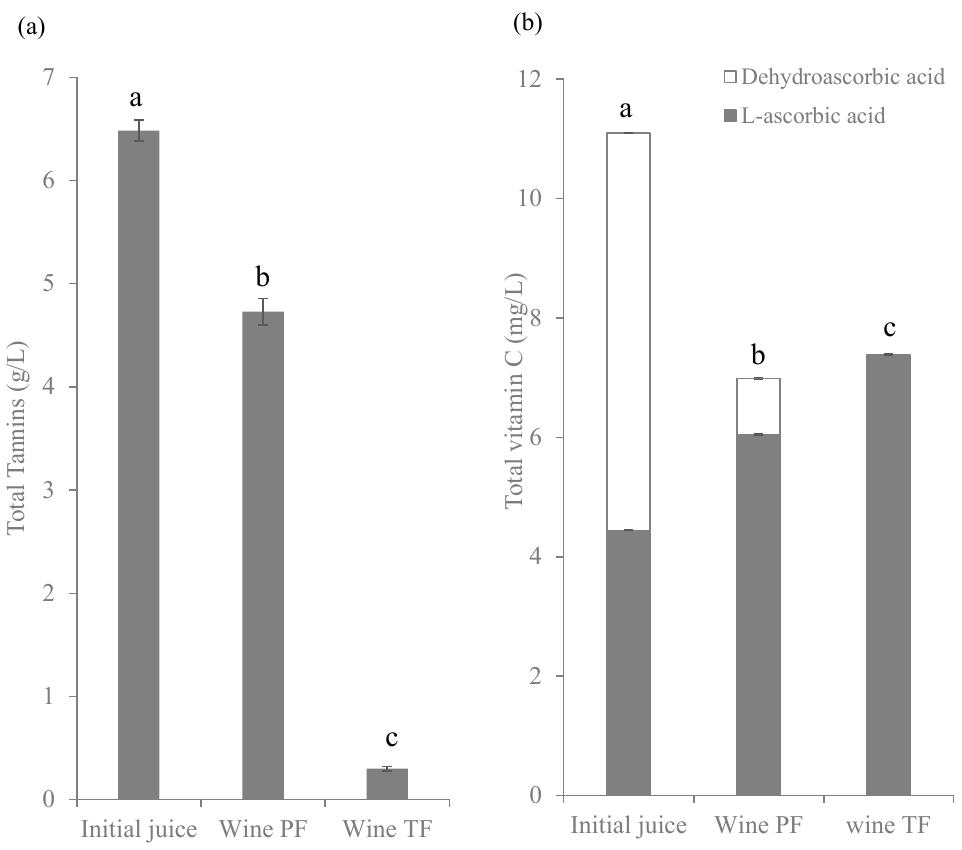
Figure 5. Concentration (g/L) of total tannins ( a ) and (mg/L) total vitamin C ( b ) in initial juice and wines from Windsor blueberry. Values with different superscript letters are significantly different, p = 0.01.